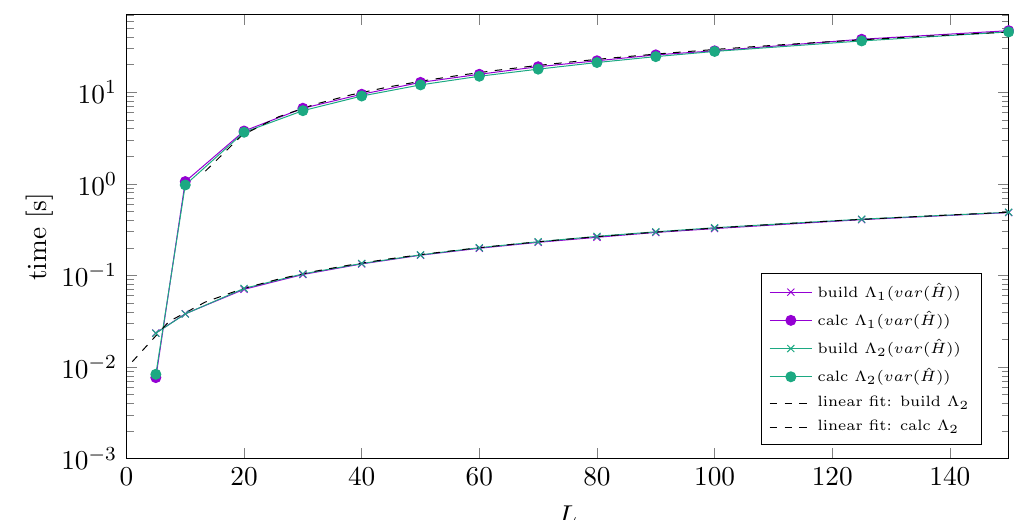
Figure 9: Computational time to construct and calculate the variance via graph representations Λ ( var ( ˆ H )) for a S = 1 Heisenberg chain in a random state with matrix dimension 1,2 Heisenberg D = 100 in every non-vanishing MPS site-tensor